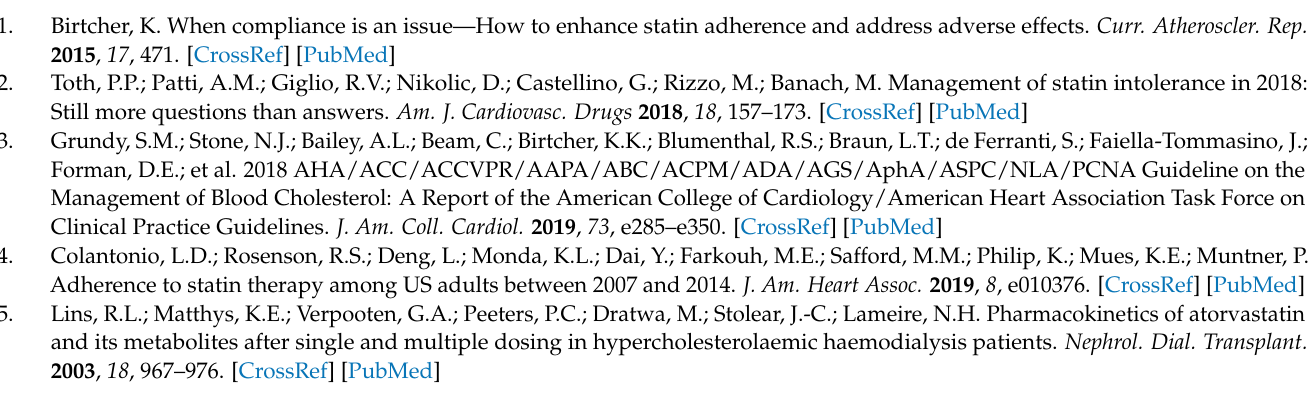
Table S3: Internal standard-corrected matrix factors (IMF) influencing the quantitation of the acid and lactone forms of atorvastatin and its hydroxylated metabolites, Table S4: Demographic information on the subjects included in the